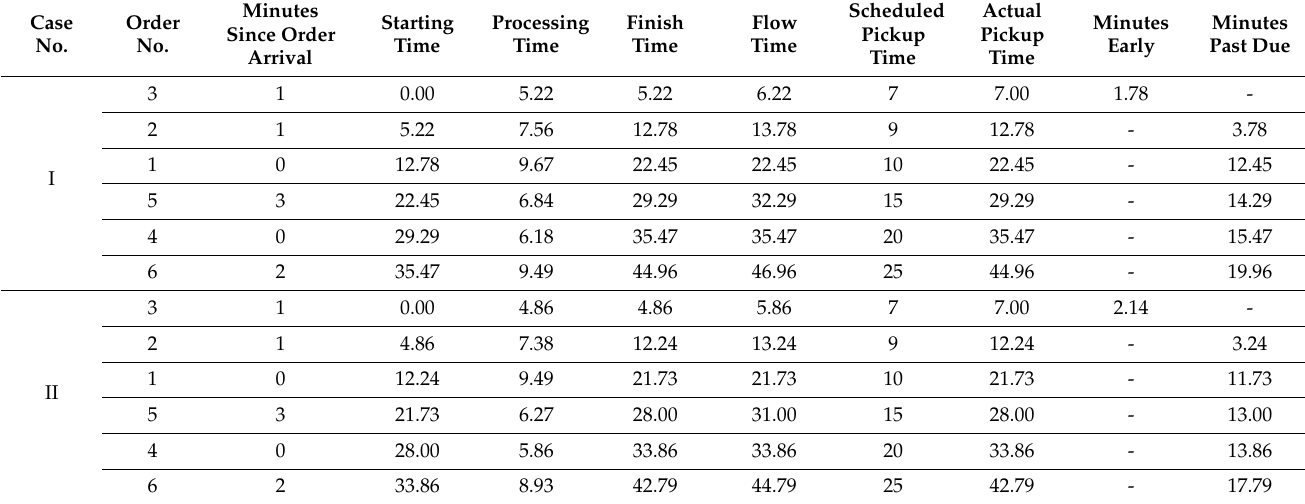
Table 6. Sequence of orders based on the EDD rule.